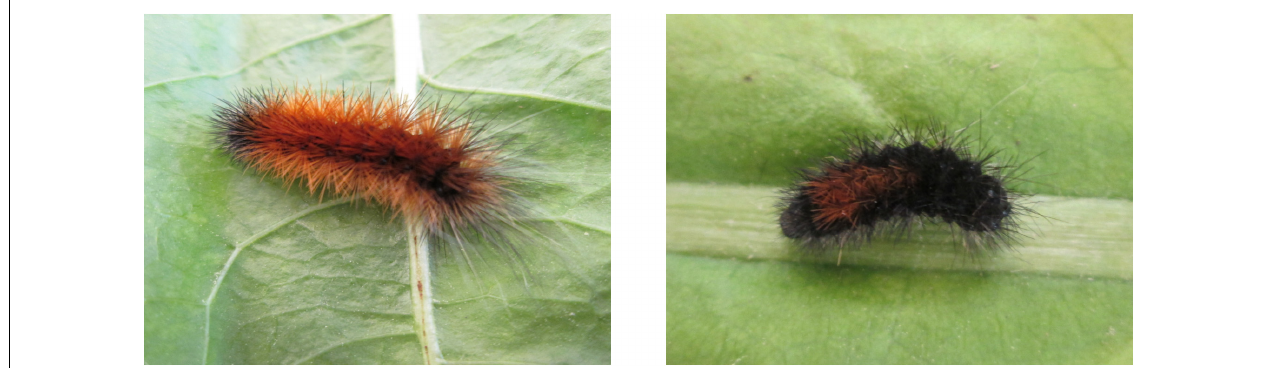
FIGURE 1 | Variation in larval warning signal. Large orange patch (left) and small orange patch (right) .